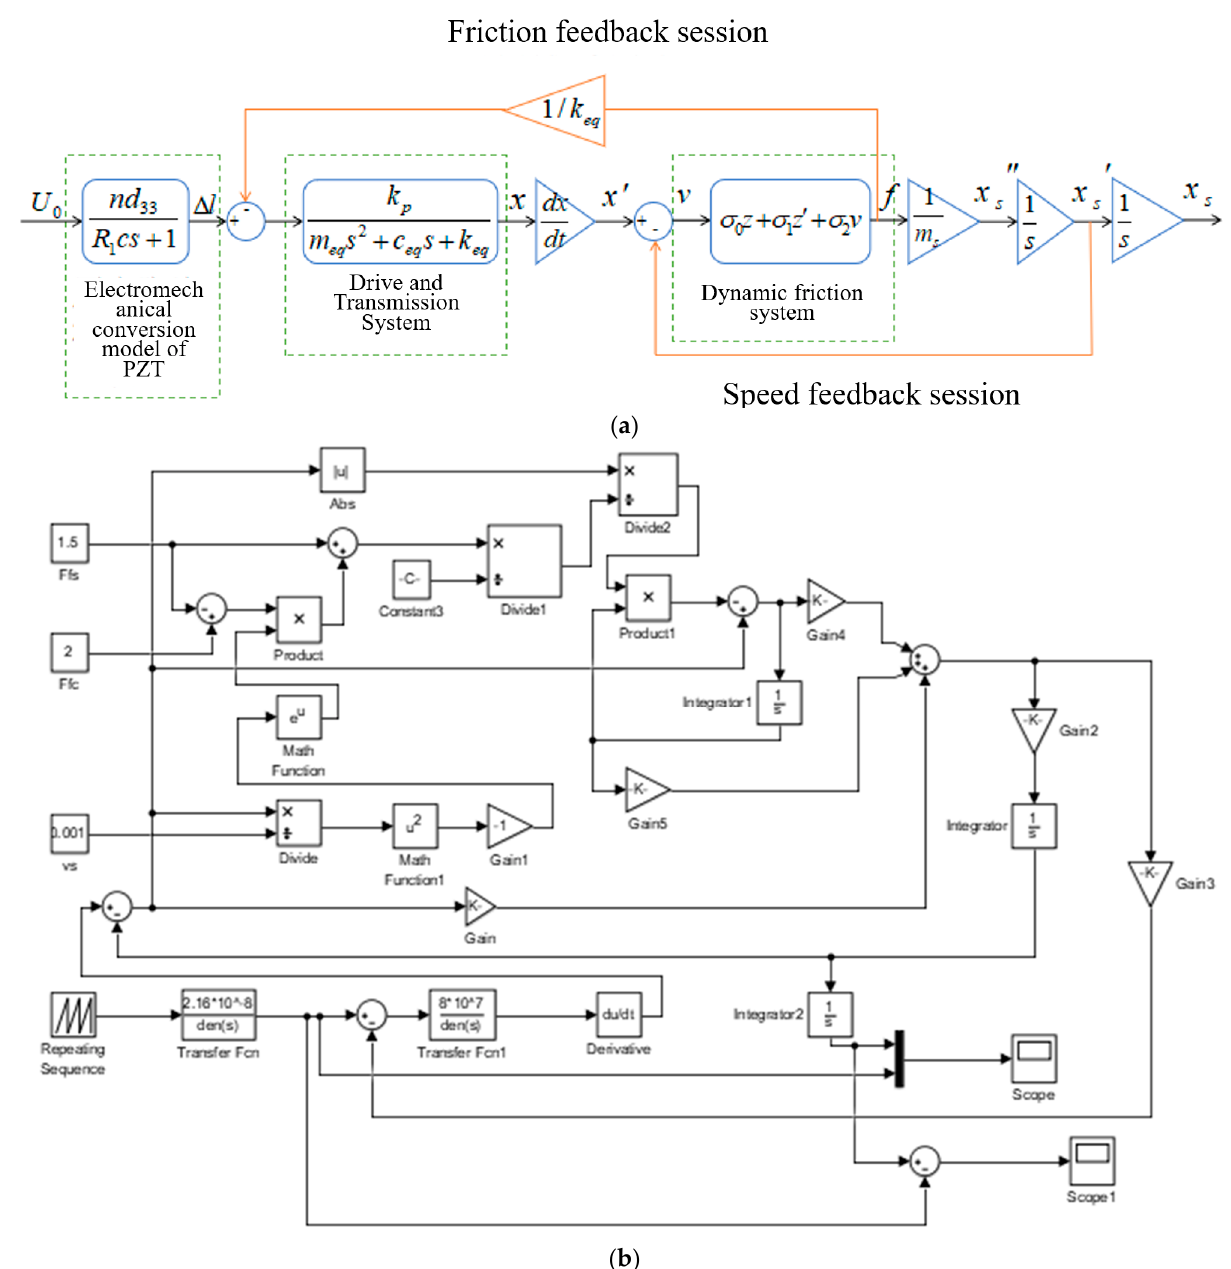
Figure 4. ( a ) Nanopositioning stage system dynamics model transfer flow chart and ( b ) simulation model of the nanopositioning stage.